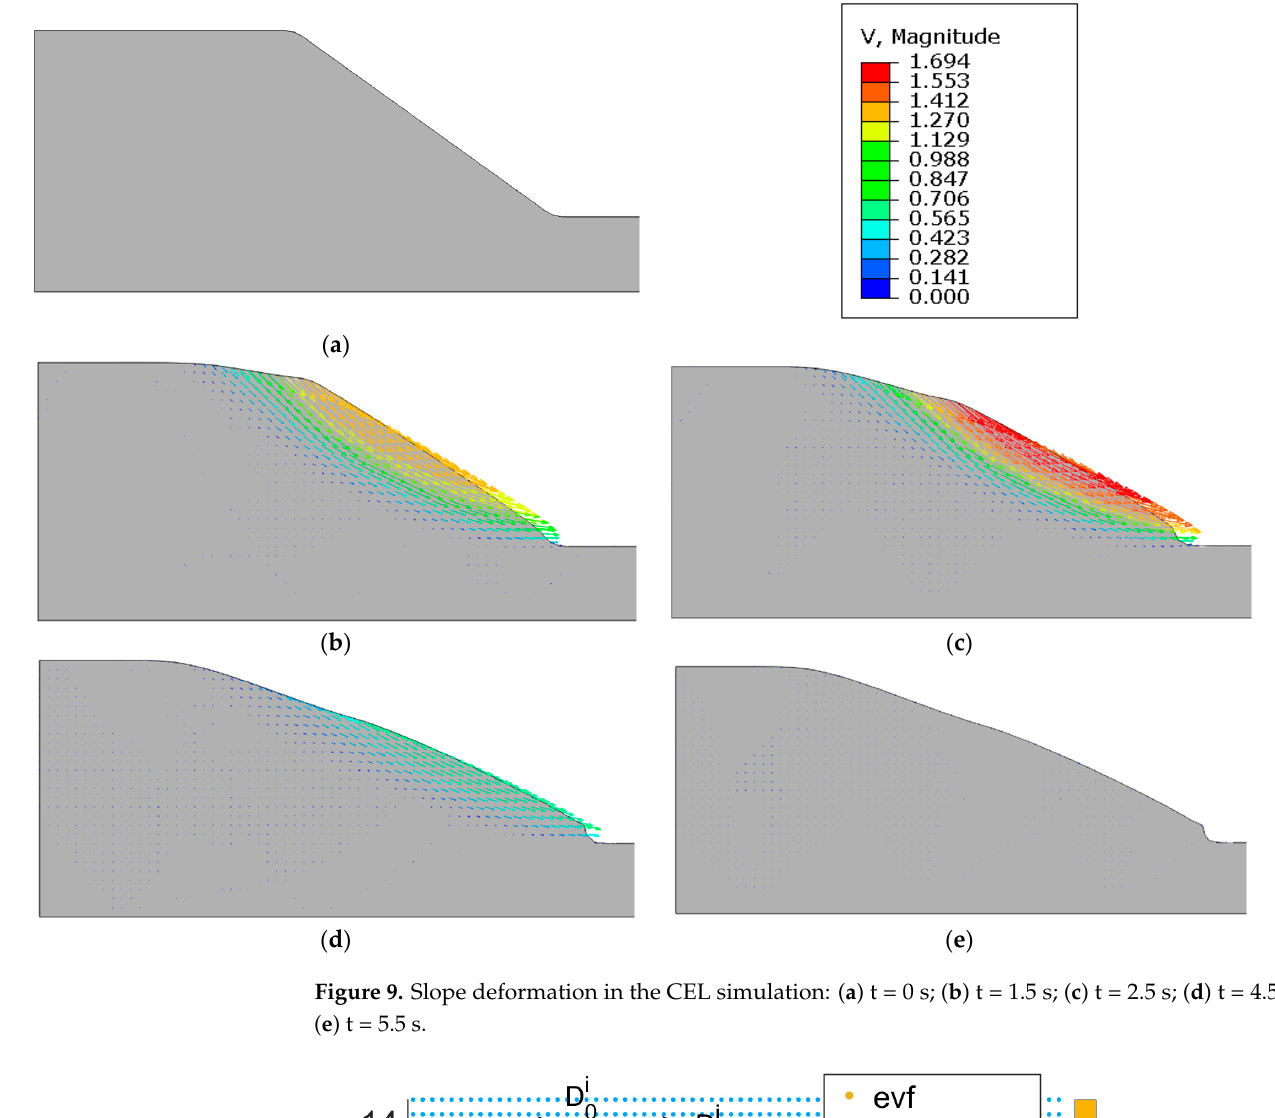
Figure 9. Slope deformation in the CEL simulation: ( a ) t = 0 s; ( b ) t = 1.5 s; ( c ) t = 2.5 s; ( d ) t = 4.5 s; ( e ) t = 5.5 s.